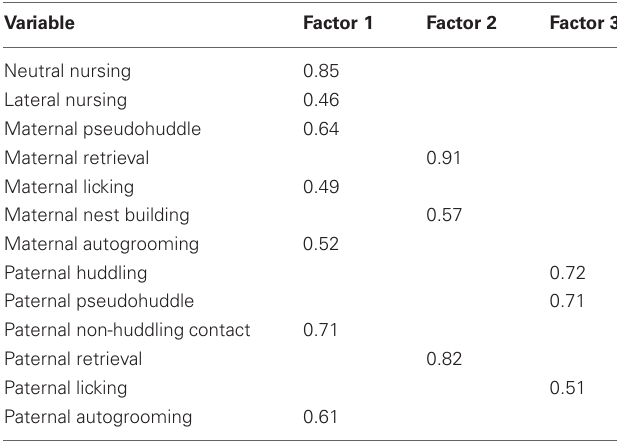
Table 3 | Factor loadings for extracted parental behavior